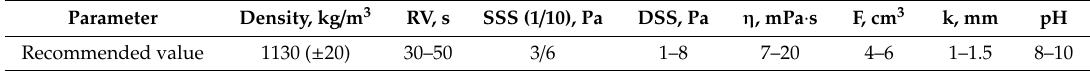
Table 3. Necessary technological properties of the drilling mud.